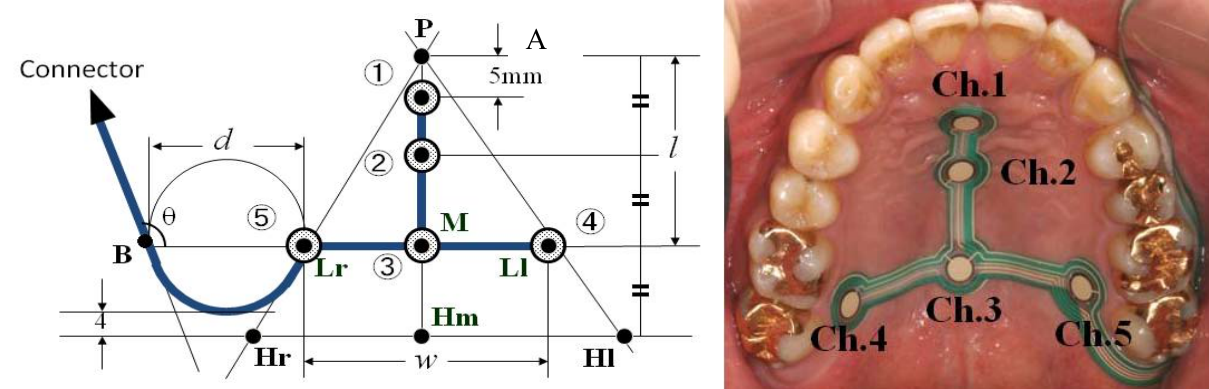
Figure 12. Design of the sensor sheet for measuring tongue pressure (A) and positioning of the sheet on the hard palate with denture adhesive (B)